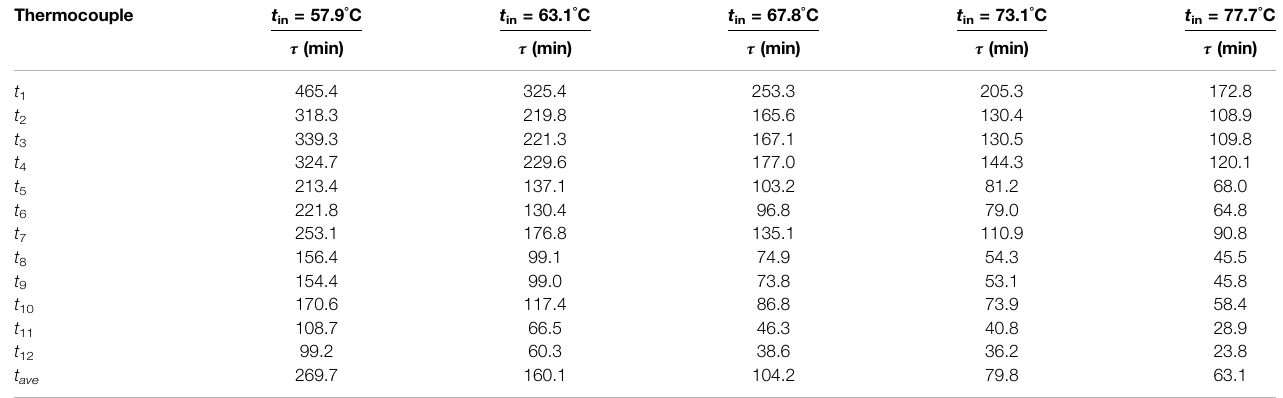
TABLE 3 | Time required for the PCM temperature attained to 50 ° C.